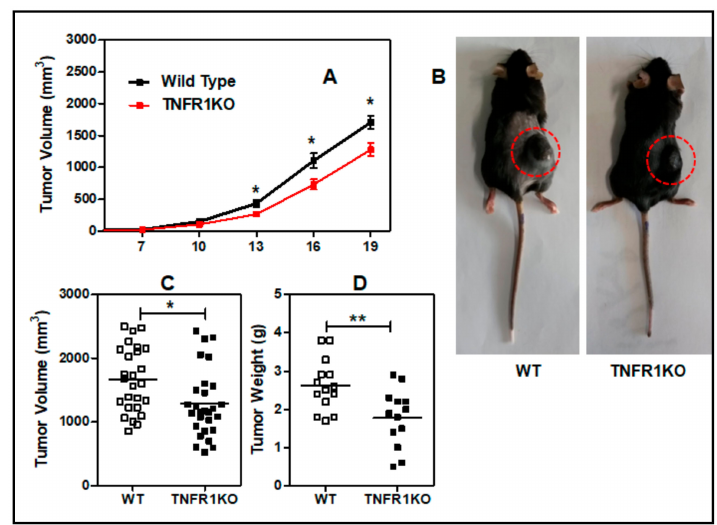
Figure 1. Lack of TNFR1 impairs tumor growth in the B16.F1 melanoma model. ( A ) B16F1 melanoma cells were subcutaneously implanted into WT and TNFR1 KO mice and tumor volume was determined by the formula d 2 × D × 0.5 at the indicated days. Data are mean ± SEM of 5 independent experiments (5–6 mice per group). ( B ) Representative photographs of WT and TNFR1 KO-bearing mice at day 19 post-inoculation ( C ) Tumor volume ( D ) and weight at day 19 post-inoculation. Values were determined at the indicated days for individual tumors. Bars represent mean values.* p < 0.05; ** p < 0.01. d: smaller diameter; D: larger diameter.